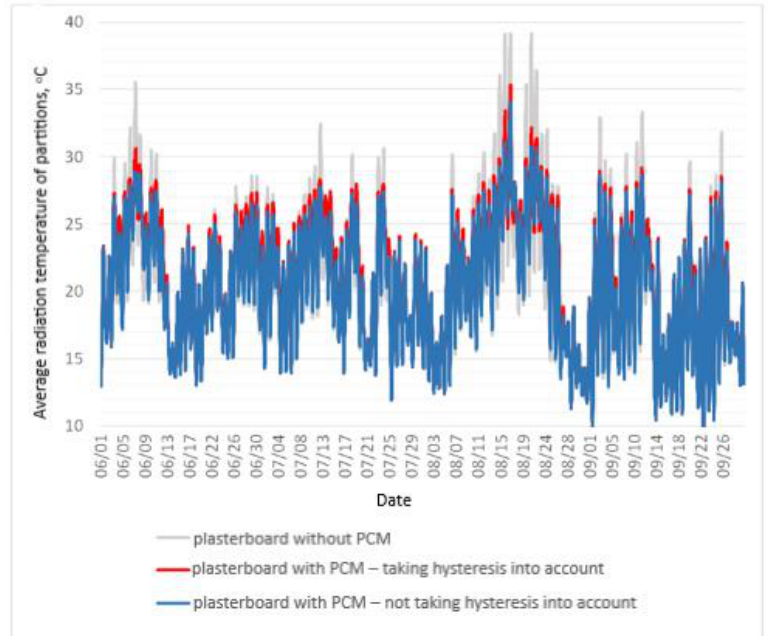
Figure 6. Average hourly values of radiation temperature of partitions in a building with plasterboards.